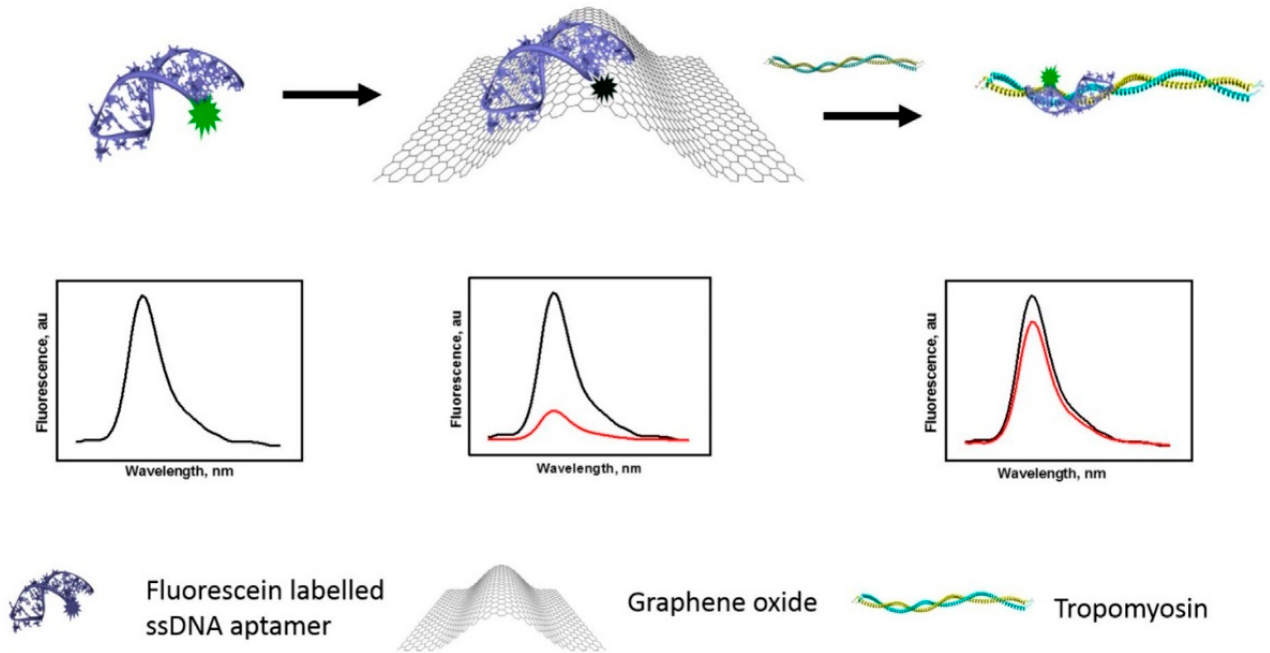
Figure 14. Optical aptasensor for detection of tropomyosin in food. Fluorescein-tagged aptamers are adsorbed on GO and used to detect tropomyosin according to a GO-induced quenching. When tropomyosin binds to the aptamers, they detach from the carbon surface to the solution and recover the fluorescence signal. Image adapted from [102] with permission of Elsevier, 2020.